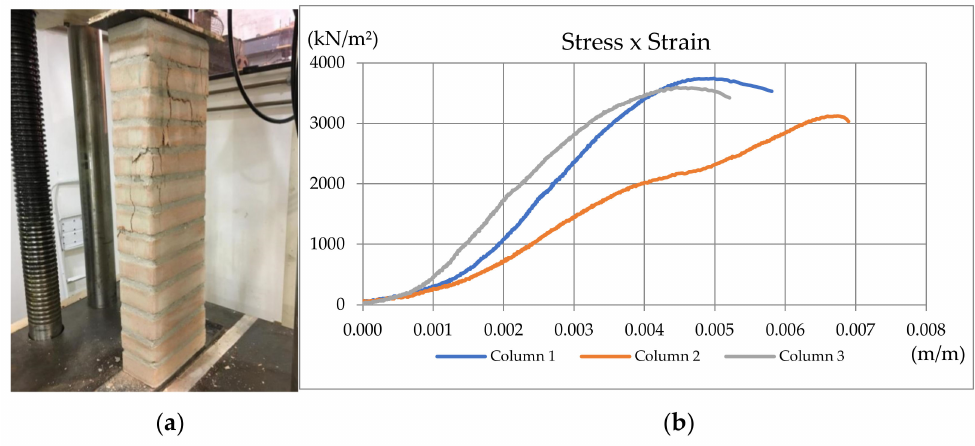
Figure 14. ( a ) Column Specimen 1; ( b ) Stress–strain curve for fully grouted column specimens